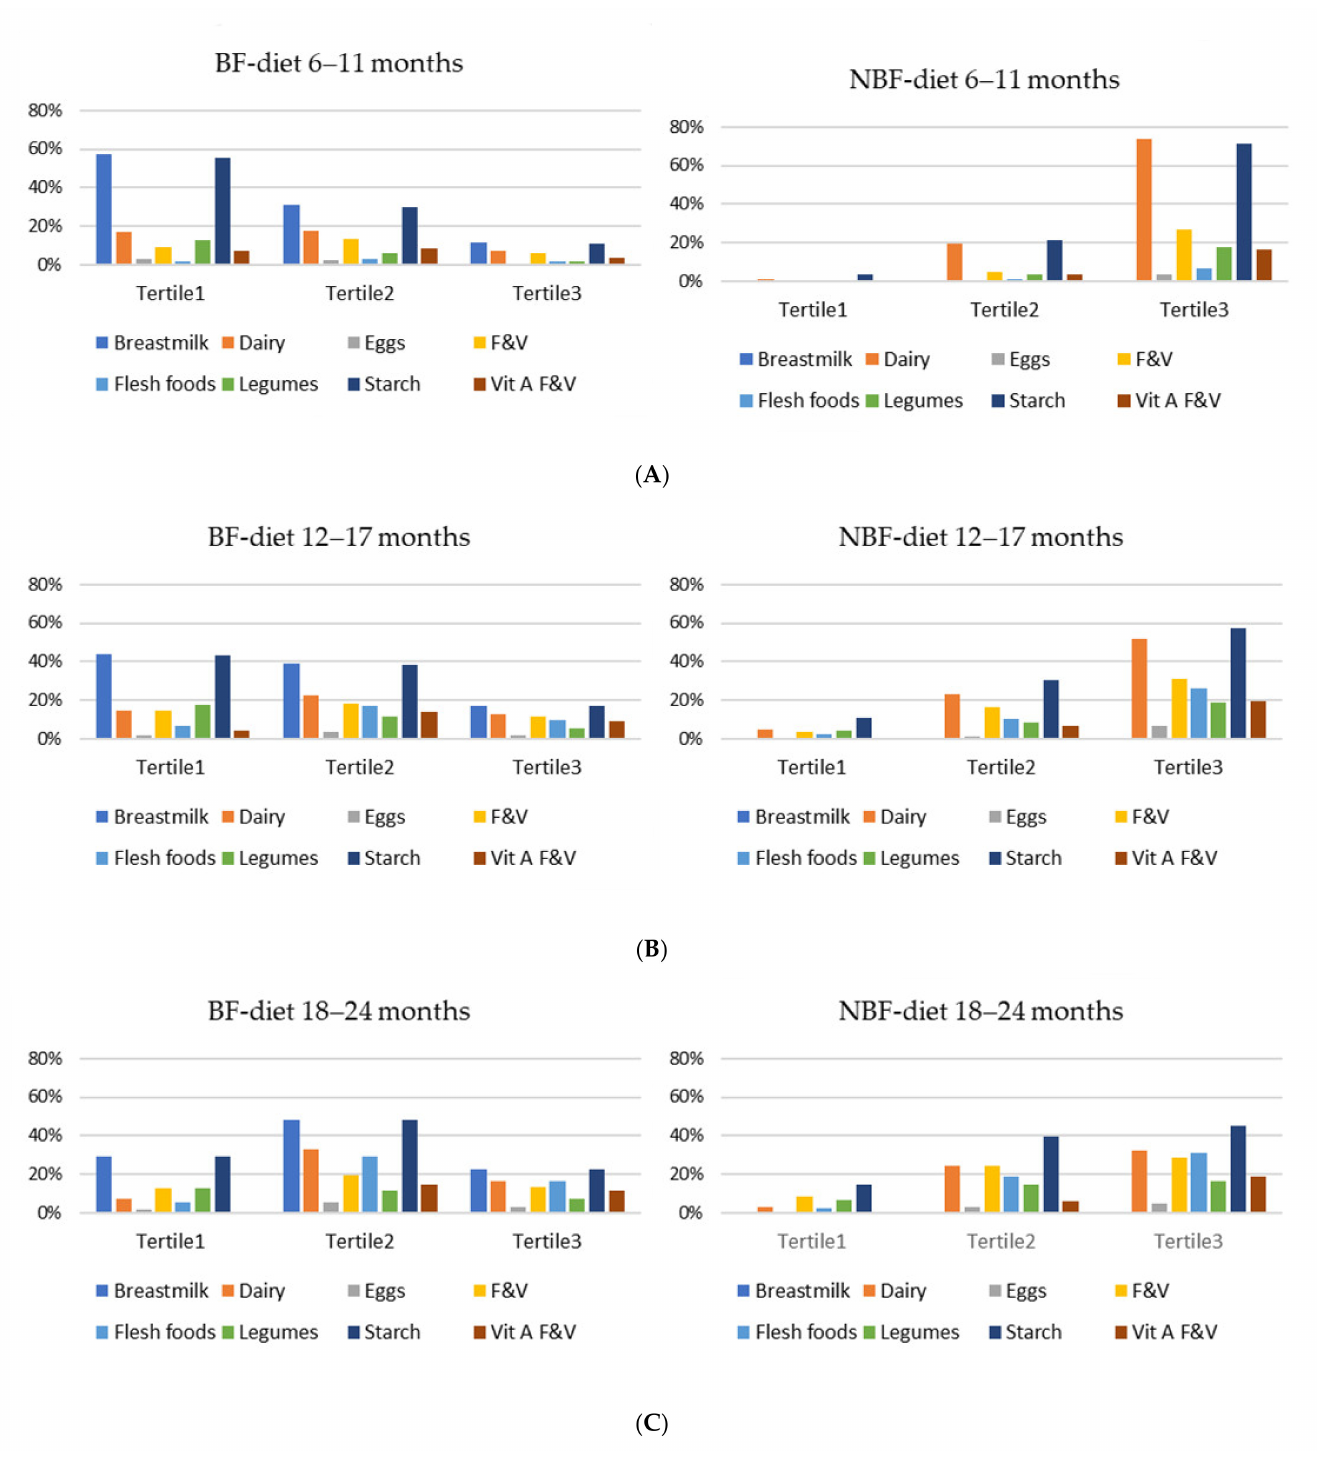
Figure 3. ( A ). Food groups included in the BF and NBF diets across the cost tertiles for 6–11 months. ( B ). Food groups included in the BF and NBF diets across the cost tertiles for 12–17 months. ( C ). Food groups included in the BF and NBF diets across the cost tertiles for 18–24 months. BF, breastfed; F&V, fruits and vegetables; NBF,